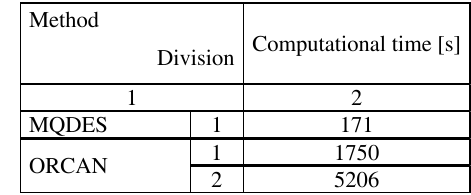
Table 2 . Analysis of computational